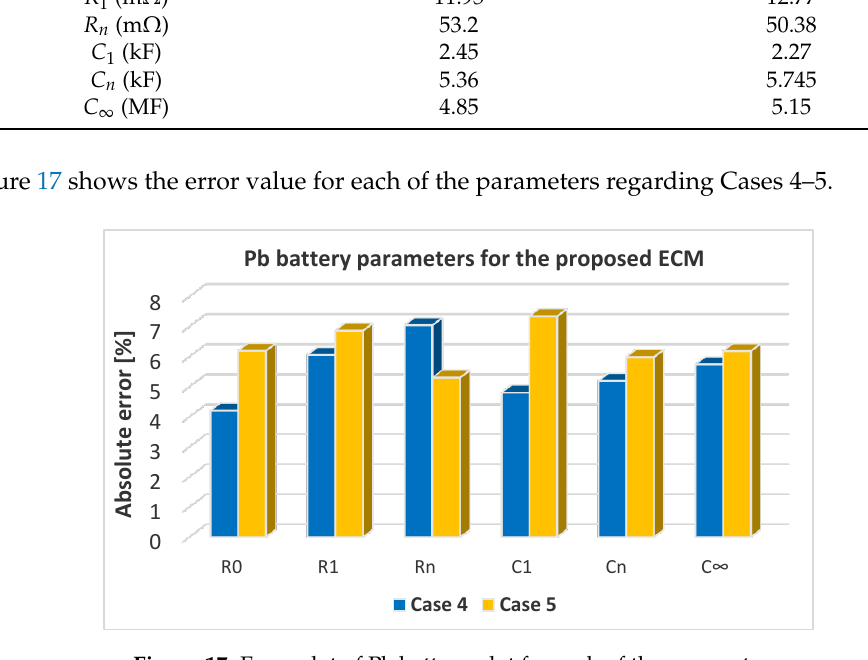
Table 18. Results of Case 5 for Pb.